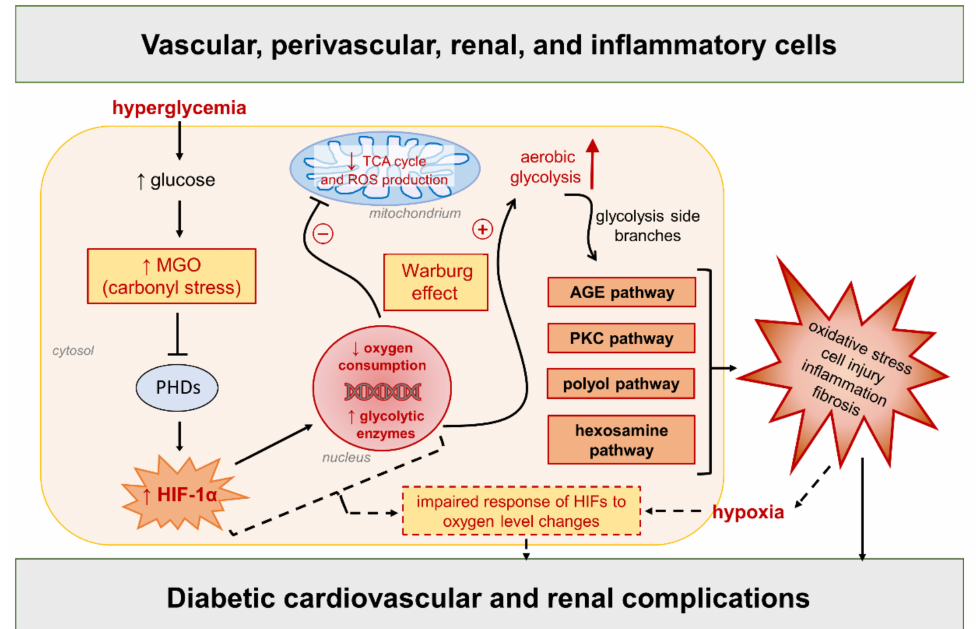
Figure 4. Link between glucose-derived carbonyl stress and the Warburg effect as a new unifying hypothesis of diabetic complications [5,43], alternative to the overproduction of mitochondrial reac- tive oxygen species (ROS) induced by hyperglycemia. Refer to the main text for detailed description and references. Dashed arrows/lines/box = subsequent processes (or “second hit”) participat- ing in the progression of diabetic complications. TCA = tricarboxylic acid; MGO = methylglyoxal; AGE = advanced glycation end product; PKC = protein kinase C; PHDs = prolyl hydroxylase domain enzymes; HIF-1 α = hypoxia-inducible factor-1 α .; HIFs = hypoxia-inducible